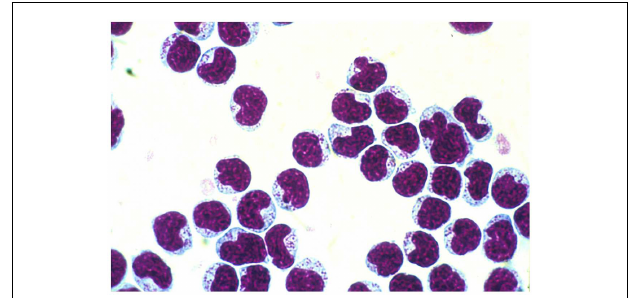
FIGURE 1 | Natural killer cells separated from peripheral blood of F344 rats on a Percoll gradient . Note the large azurophilic granule in the